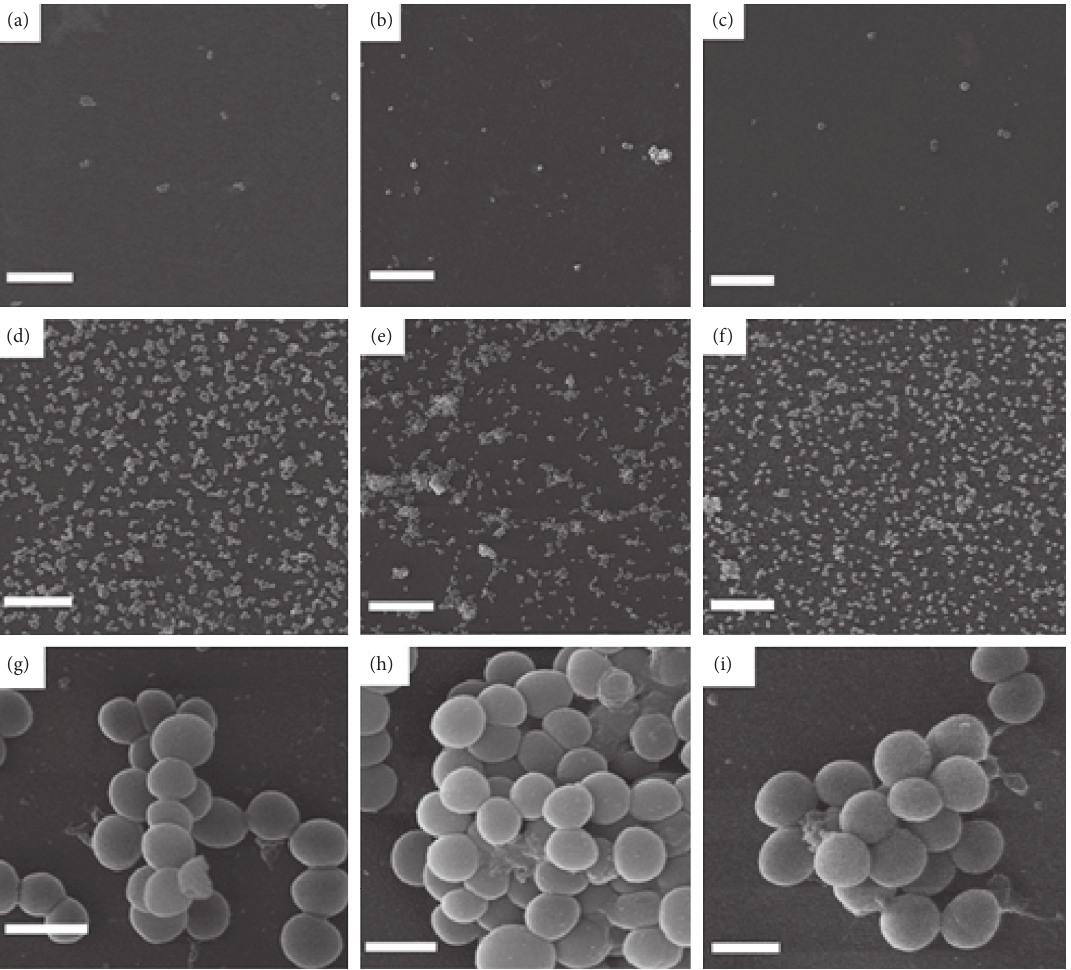
Figure 4: Scanning electron microscopy images of three strains of S. aureus . Bacteria were grown in twenty-four well tissue culture plates with Thermanox plastic coverslips at 35 ° C for 24h. (a, b, and c) SA139, SA150, and B103 strains, respectively, grown in medium without diclofenac (magnification: 4000x); (d, e, and f) SA139, SA150, and B103 strains, respectively, grown in medium with diclofenac (mag- nification: 4000x); and (g, h, and i) images of the respective strains grown in medium with diclofenac (magnification: 40000x). Scale bars: (A, B, C, D, and F) � 10 μ m; (G, H, and I) � 1 μ